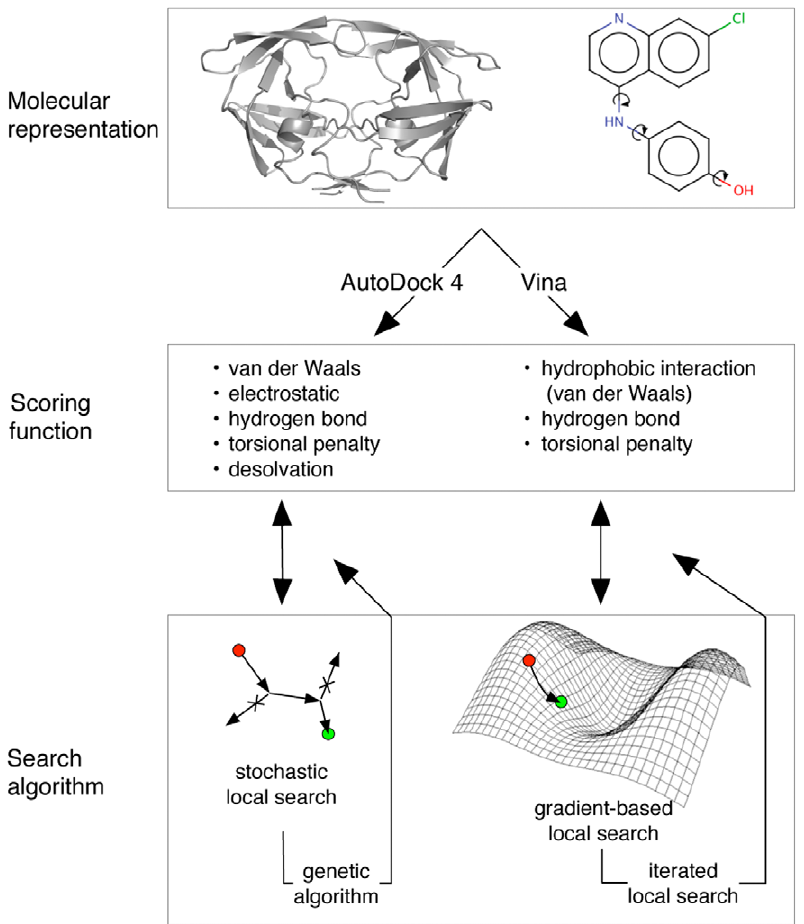
Figure 1. Comparing the methodologies of AD4 and Vina. Both programs use the same type of input files describing the receptor (generally rigid) and flexible ligand. The scoring functions have similar parameters, but have been calibrated differently. A key difference between the programs is the local search algorithm. AD4 uses a stochastic search which generates random conformations to test. Vina calculates a gradient while seeking a local